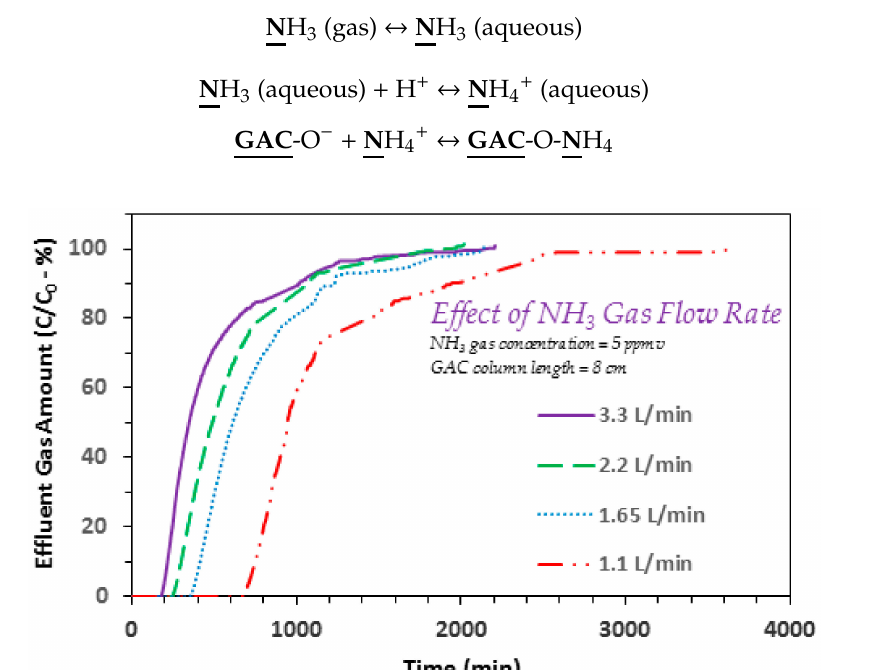
Figure 4. E ff ect of influent ammonia / NH 3 gas flow rate on the adsorption breakthrough curve profile of ammonia gas on to GAC produced from date palm pits (GAC SSA BET = 822 m 2 / g and average pore width = 23.01 Å; ammonia / NH 3 gas flow rates = 1.1, 1.65, 2.2, and 3.3 L / min; influent ammonia / NH 3 gas concentrations 5 ppmv; GAC column length = 8 cm; GAC bed dia. 6.35